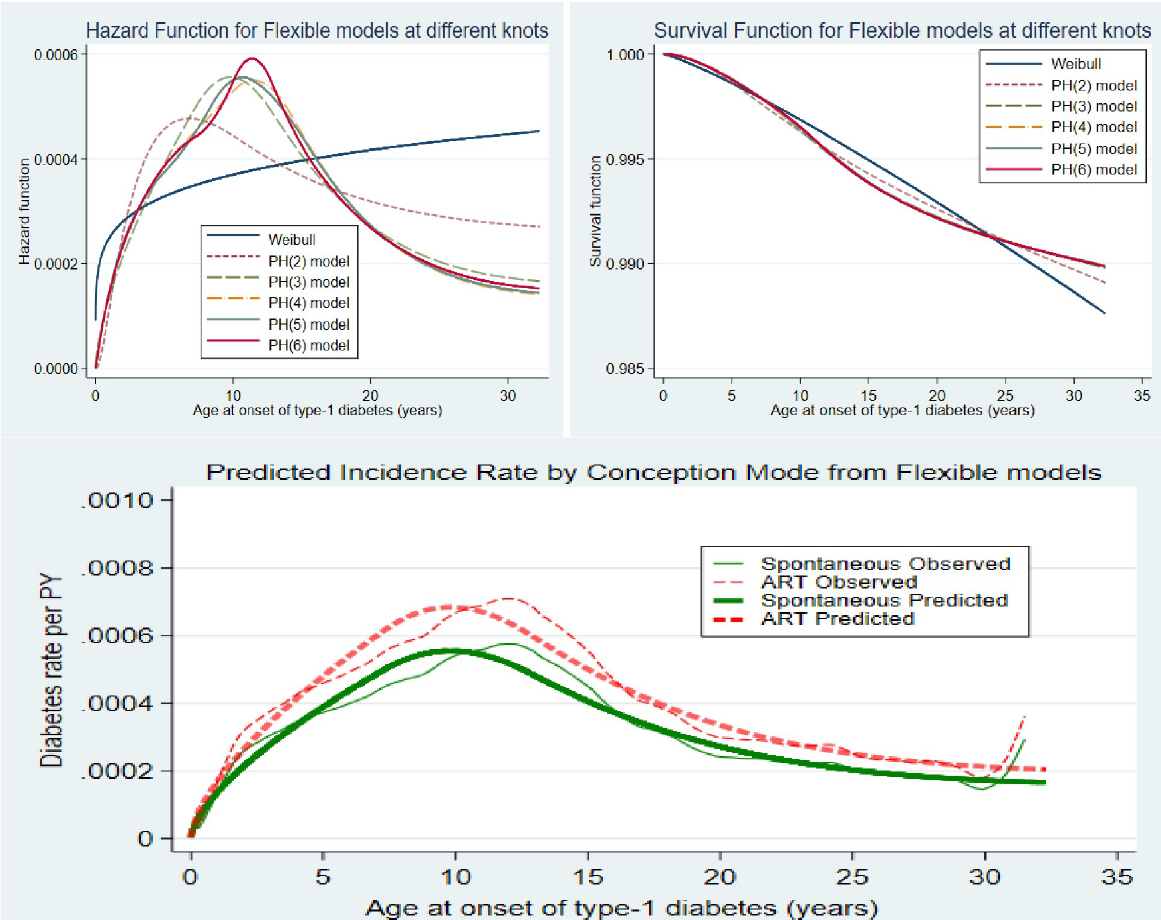
Fig 4. Comparing the hazard and survival functions of the flexible models at different